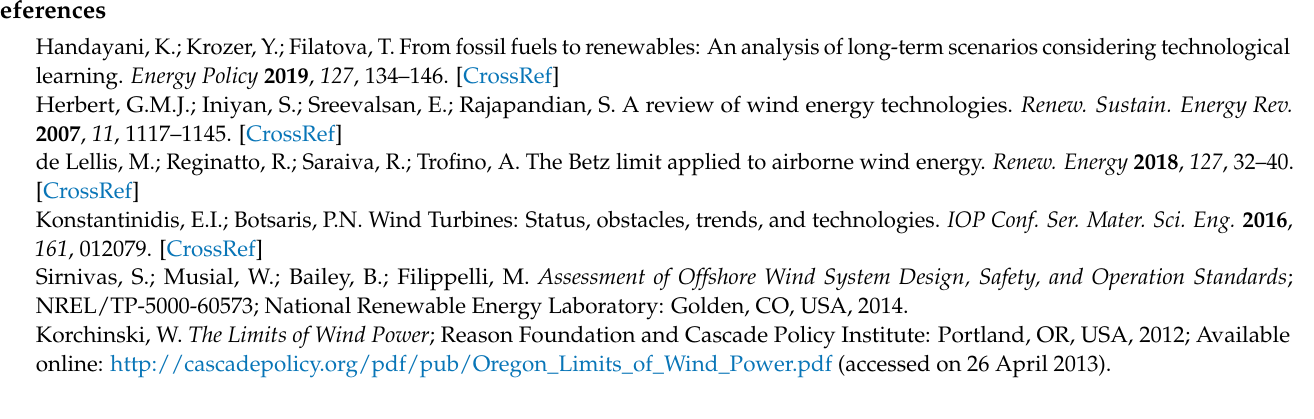
ments = 1000, red line: approximate solution, blue line: exact solution.